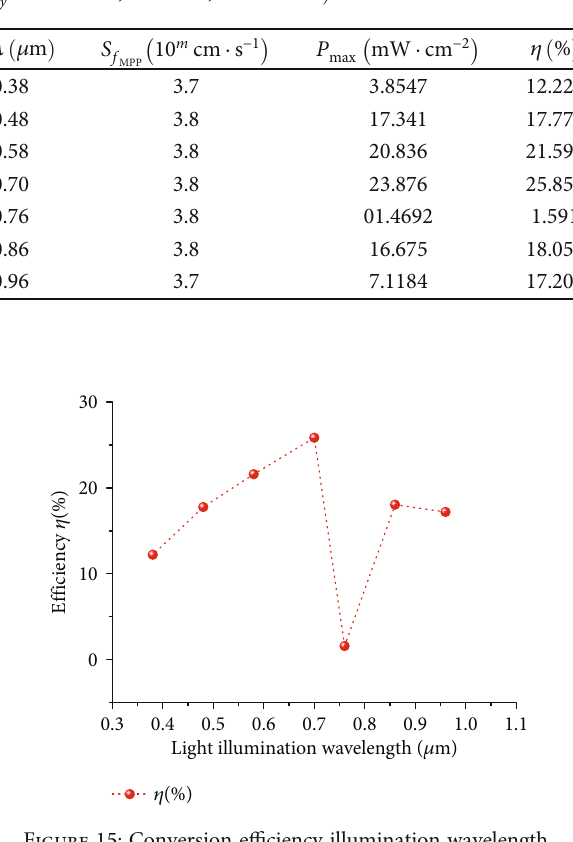
= 0 : 015cm, D = 26 cm 2 · s − 1 n n